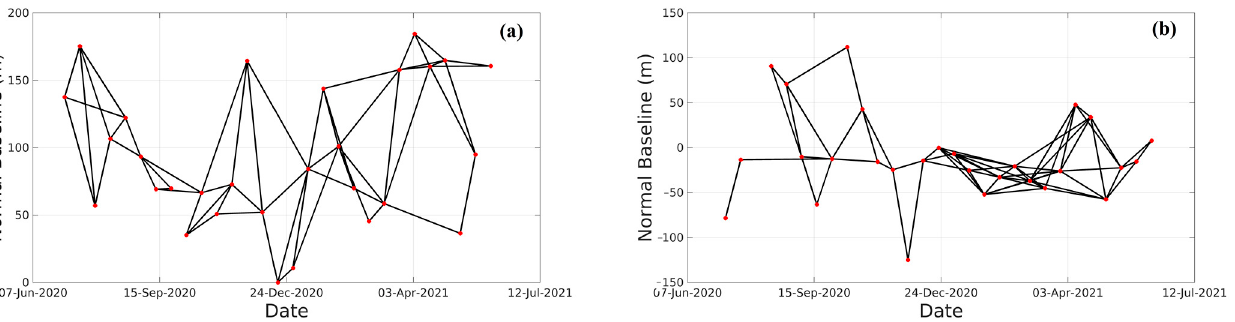
Figure 2. The interferometric combination of Small Baseline network for Sentinel-1A/B ( a ) descending and ( b ) ascending tracks. The red circles and black lines represent SAR image acquisitions and interferometric pairs, respectively.